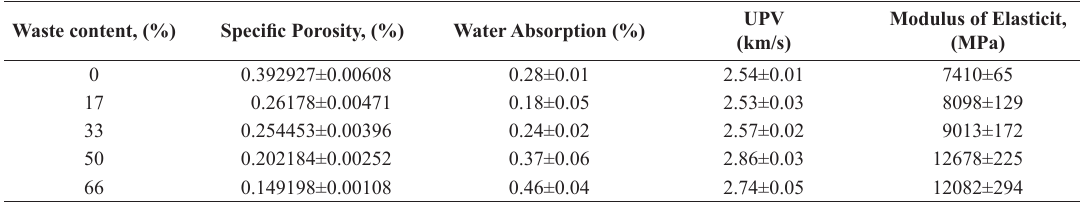
Table 3. Different properties of PCBs and (±) standard deviation. Waste content,